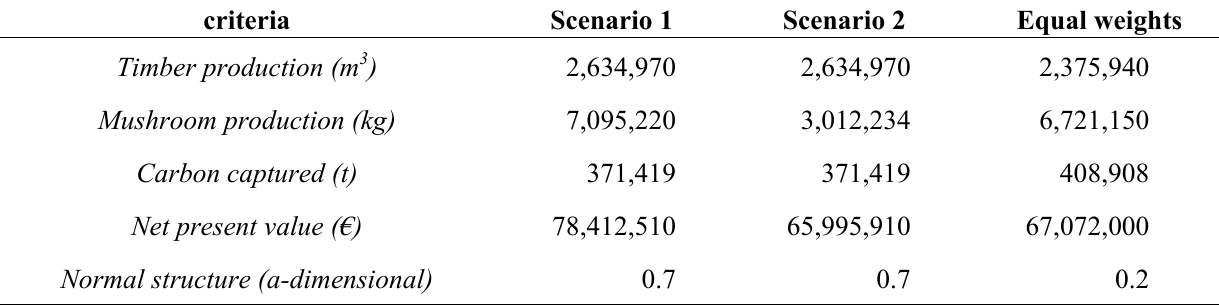
Table 4. Results of the Lexicographic Goal Programming (LGP) model for both scenarios and for the case where the preferential weights were the